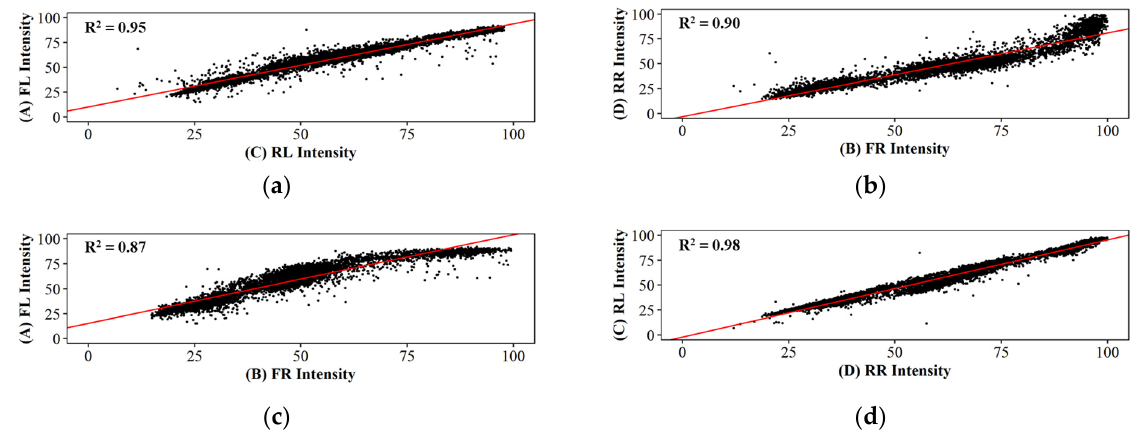
sensors comparison.